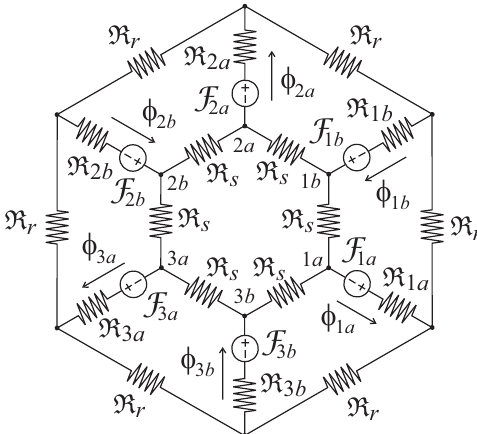
Figure 9. Equivalent circuit of the magnetic device.